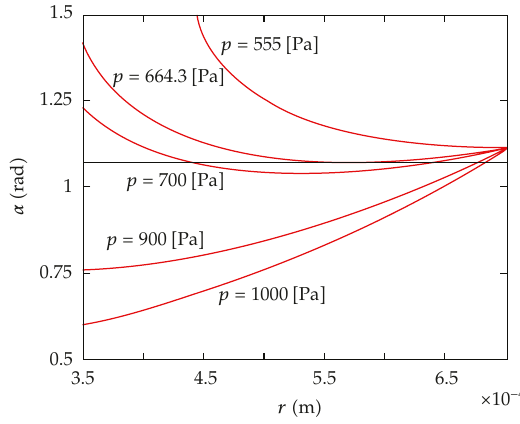
Figure 3: α versus r for p (cid:2) 555 , 664 . 3 , 700 , 900 , 1000 (cid:5) Pa (cid:7) .